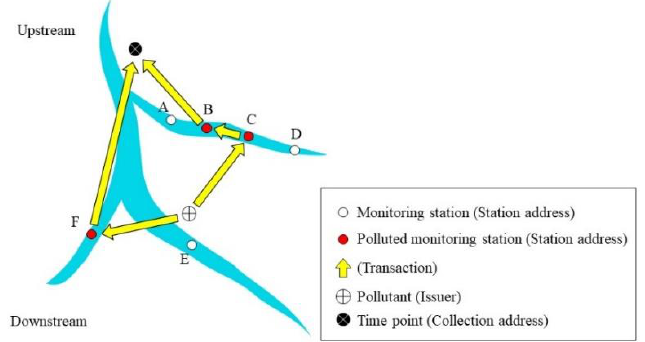
Figure 5. Example of the blockchain transaction record of pollution coins.